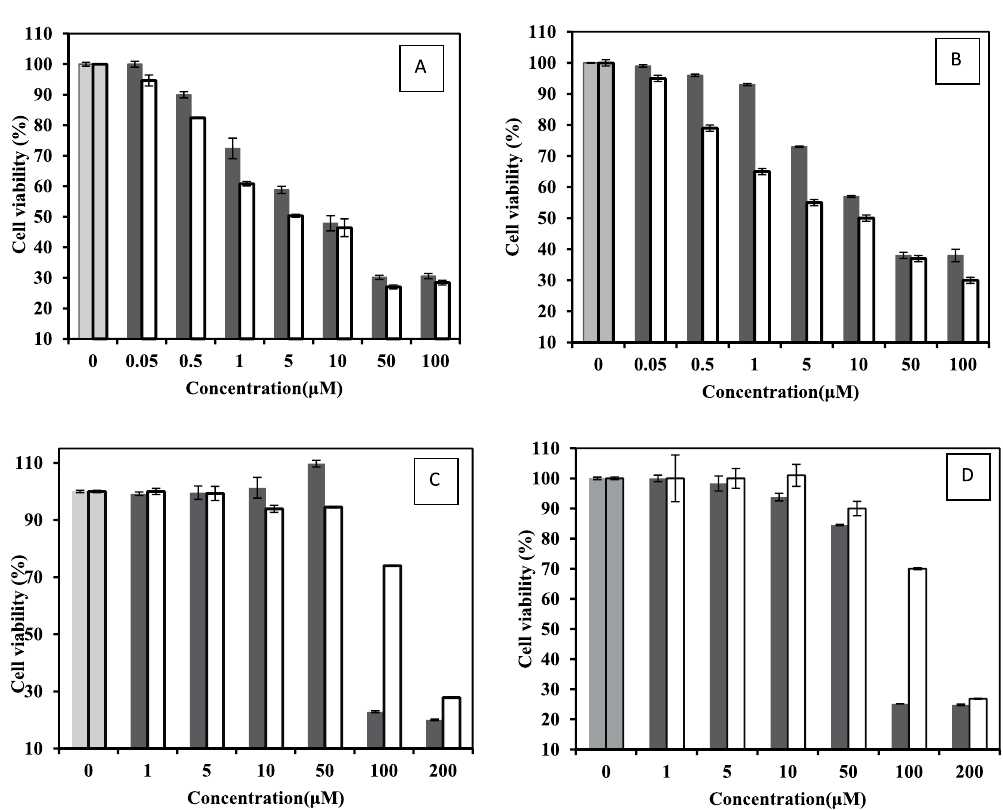
Figure 6. ( A ) Cell viability of MDA-MB 231, ( B ) MCF-7 ( C ) WBC and ( D ) MCF-10A treated with SNPs ■